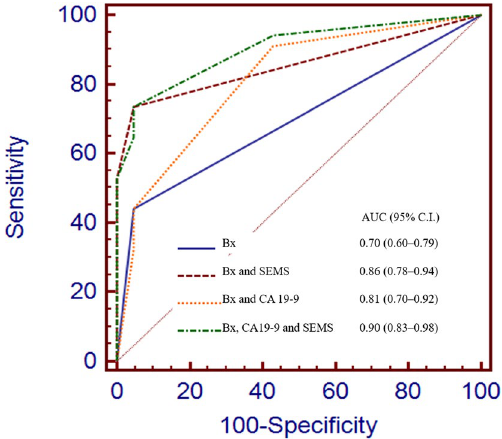
Figure 2. Receiver operating characteristic curves of each diagnostic method. AUC area under the curve, Bx endobiliary biopsy, C.I . confidence interval, SEMS self-expandable metal stent